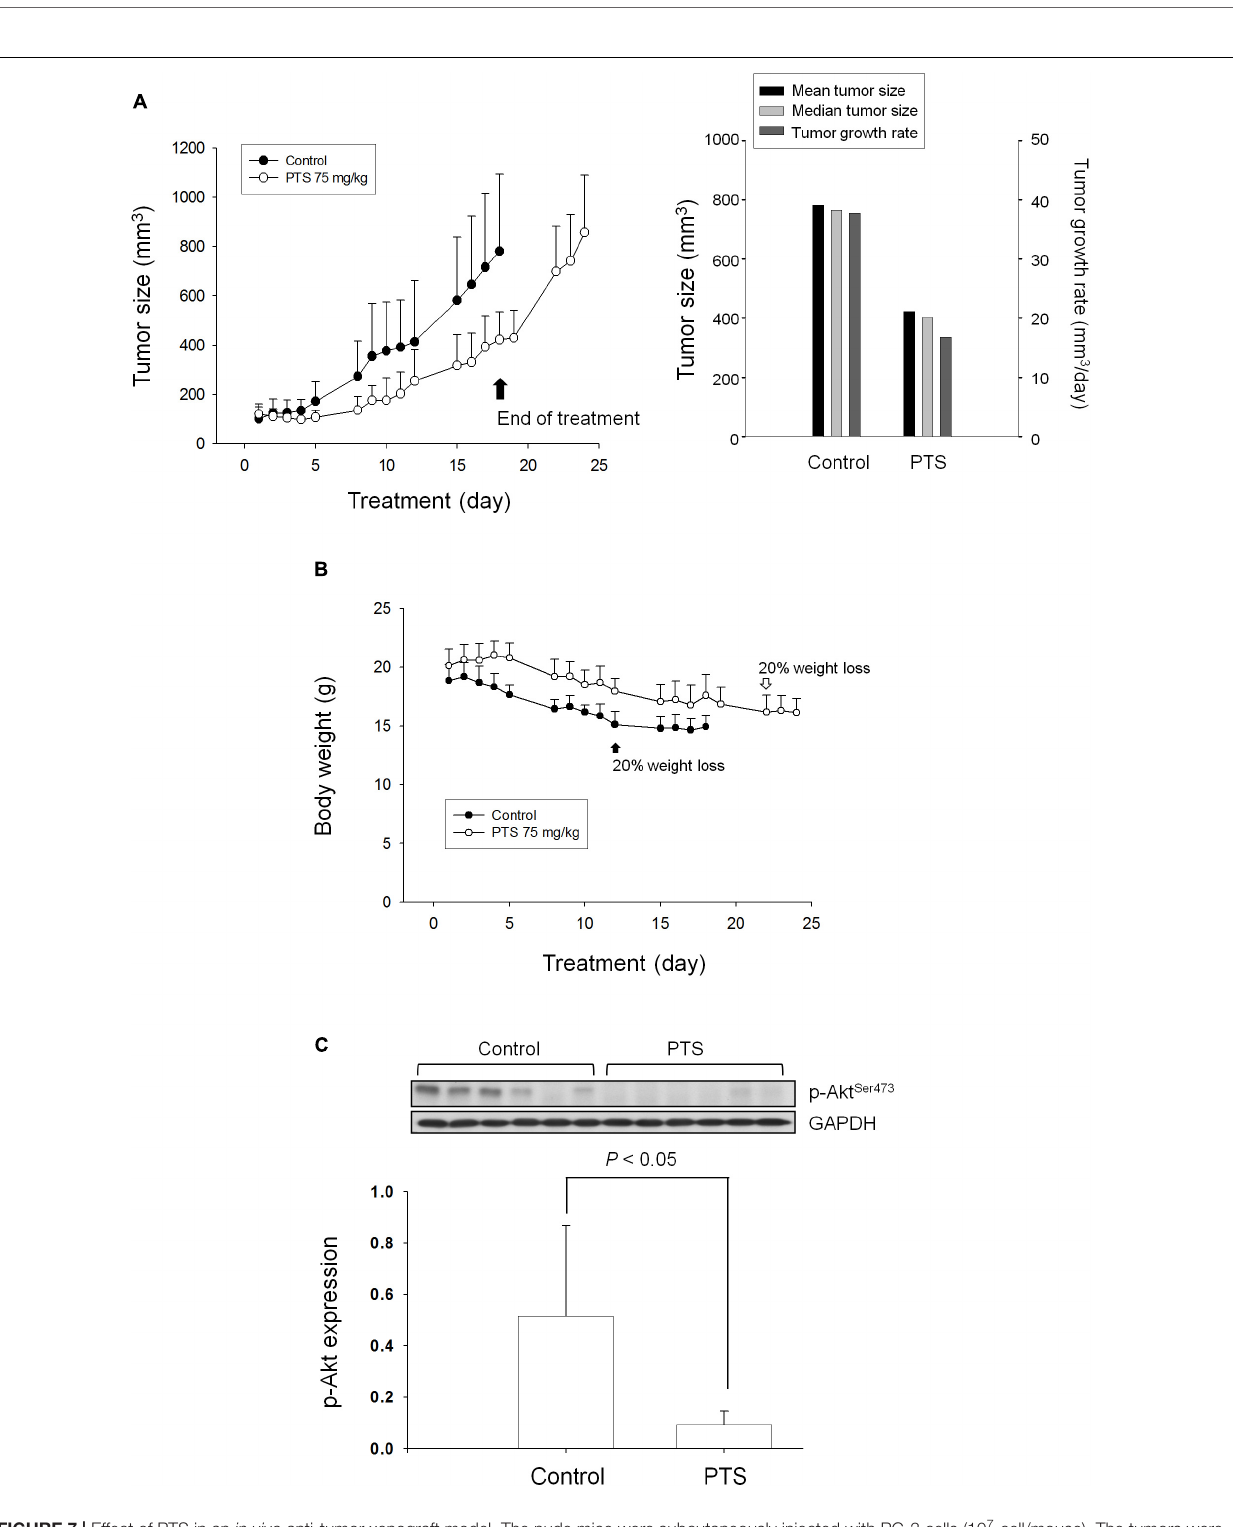
Frontiers in Pharmacology |